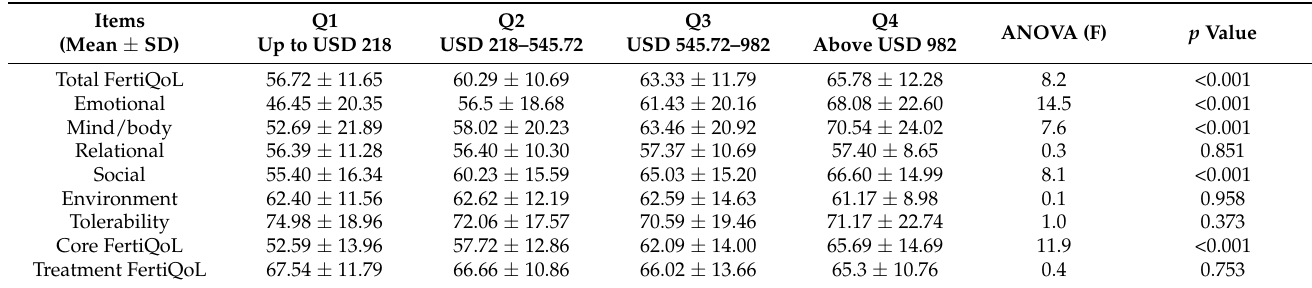
Table 5. Characteristics of average indicators of FertiQoL by